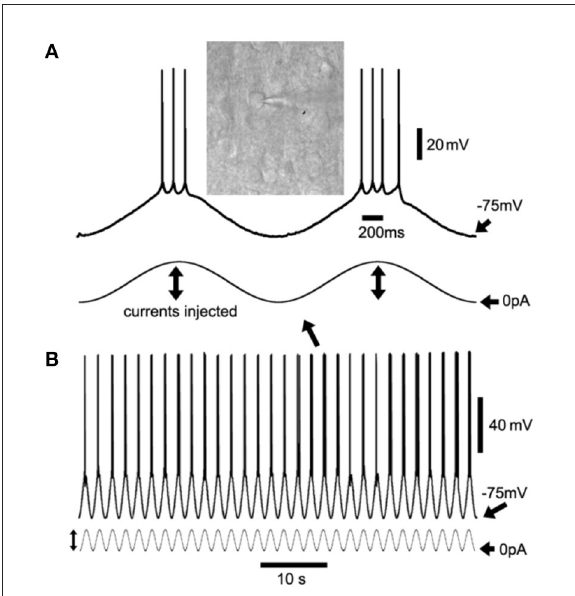
FIGURE1 Sinusoidal current injection to induce cortical neuron up/down-states as slow-wave oscillations (SWOs). (A) Shows the two consecutive up/down-states with action potentials riding at the peaks with an inset of differential interference contrast (DIC) layer V cortical neuron image, expanded from two consecutive up/down-states in (B) (with an arrow indicating). (B) Shows the 60-s episode of SWOs (0.5Hz) with injected sinusoidal current waveforms to induce neuronal up/down-states as SWOs. Scale bars are indicated as labeled. The vertical lines with dual arrows in (A,B) indicate the injected sinusoidal current amplitudes for up- (to induce action potentials) and down-states (0pA injection, unless stated in Sections “Method/Result”). The sinusoidal waves are not in the same scale in (A,B) .